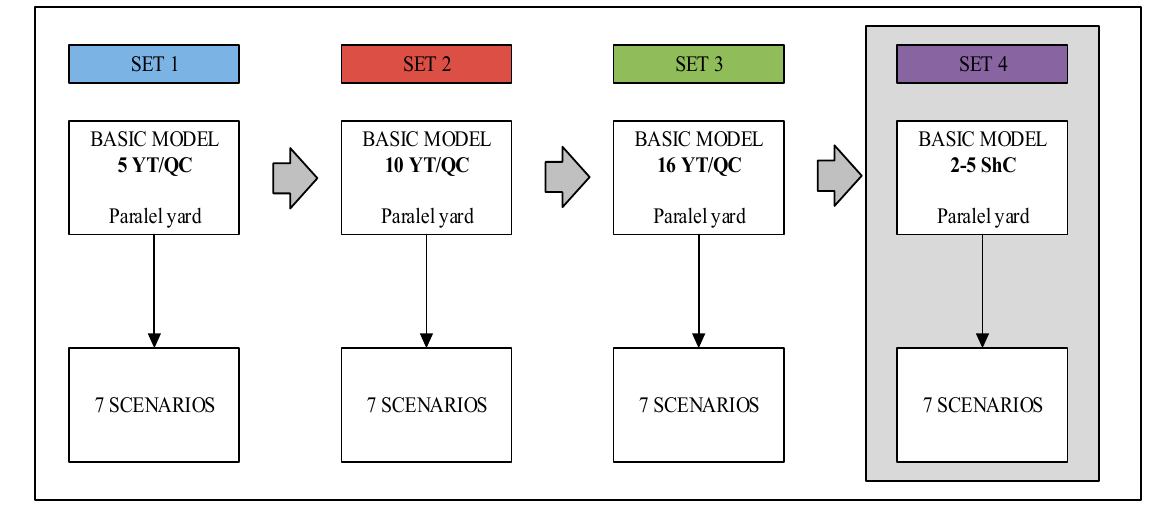
Figure 4. Four simulation sets.